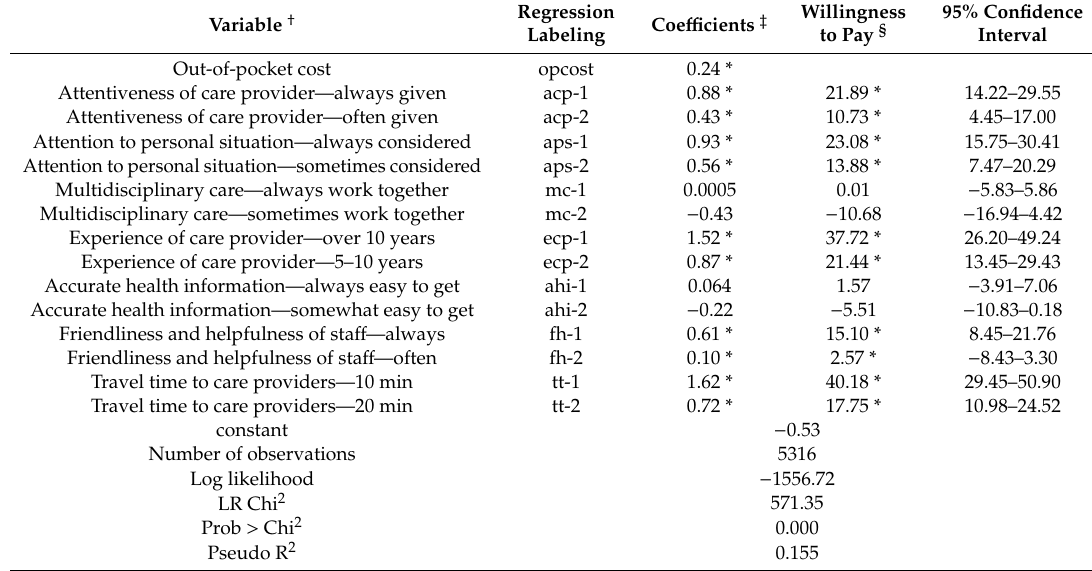
Table 3. Regression results and willingness to pay ( WTP ) for integrated